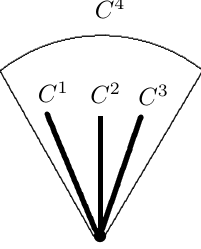
Figure 11: A plane graph D ( A ) for A = { C 1 , C 2 , C 3 , C 4 } .